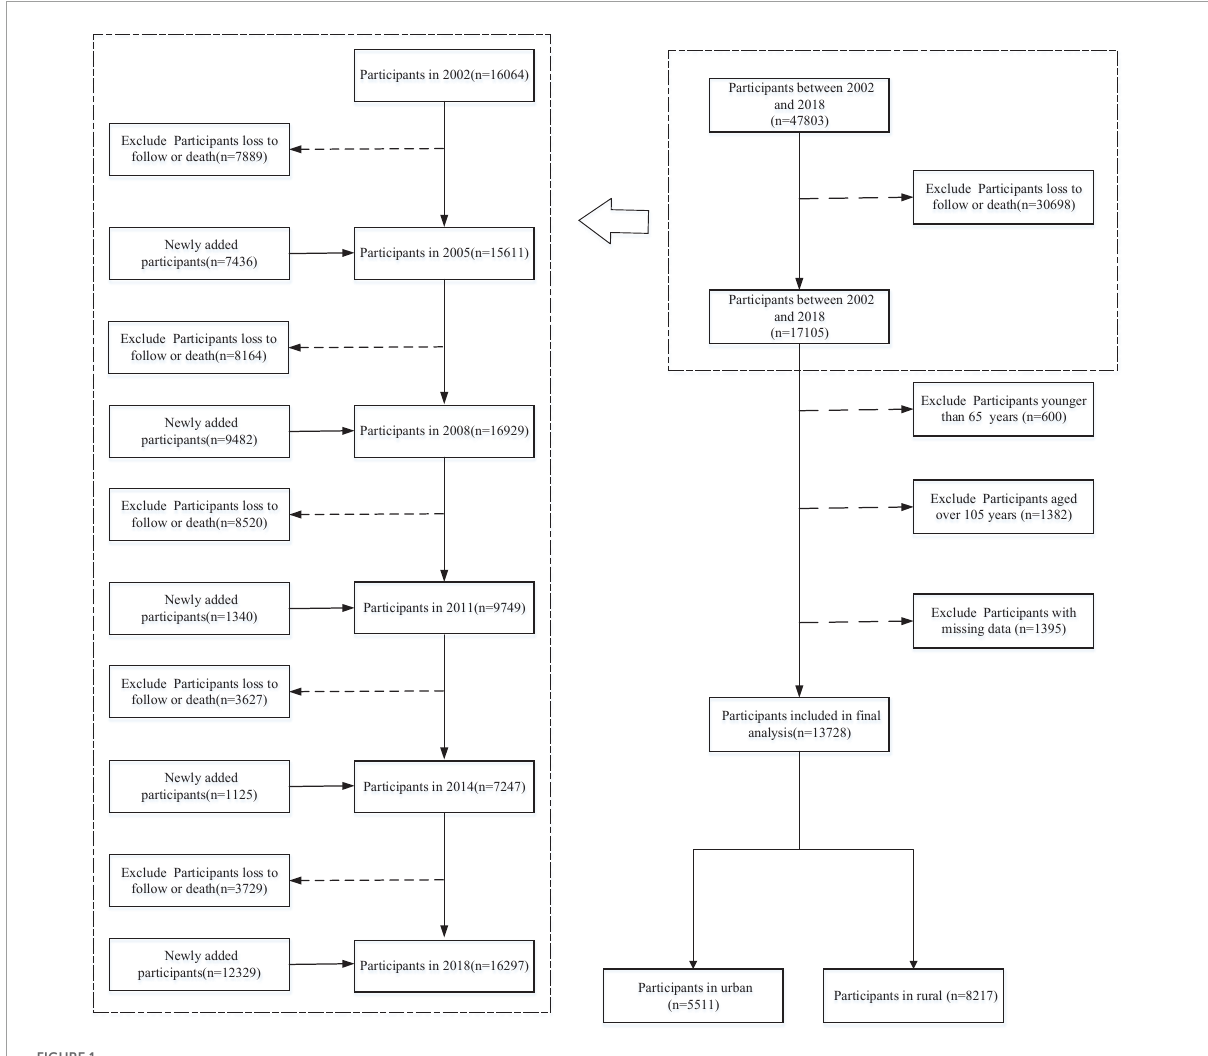
FIGURE1 Flowchart of sample